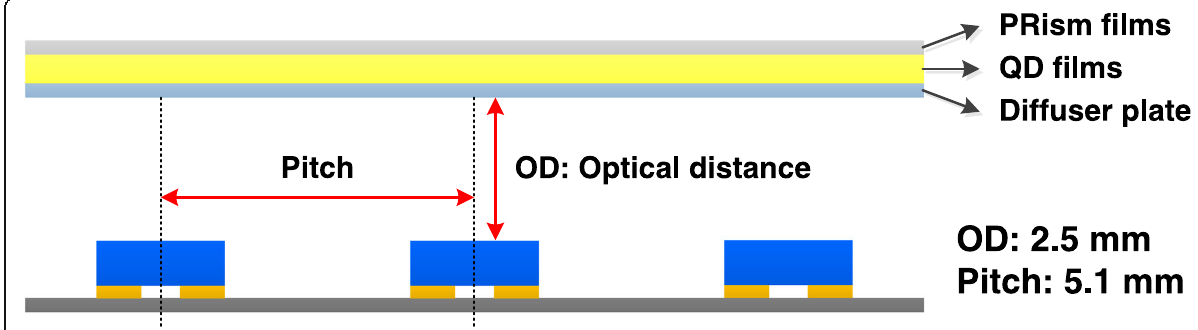
Fig. 2 Schematic diagrams of the backlight unit